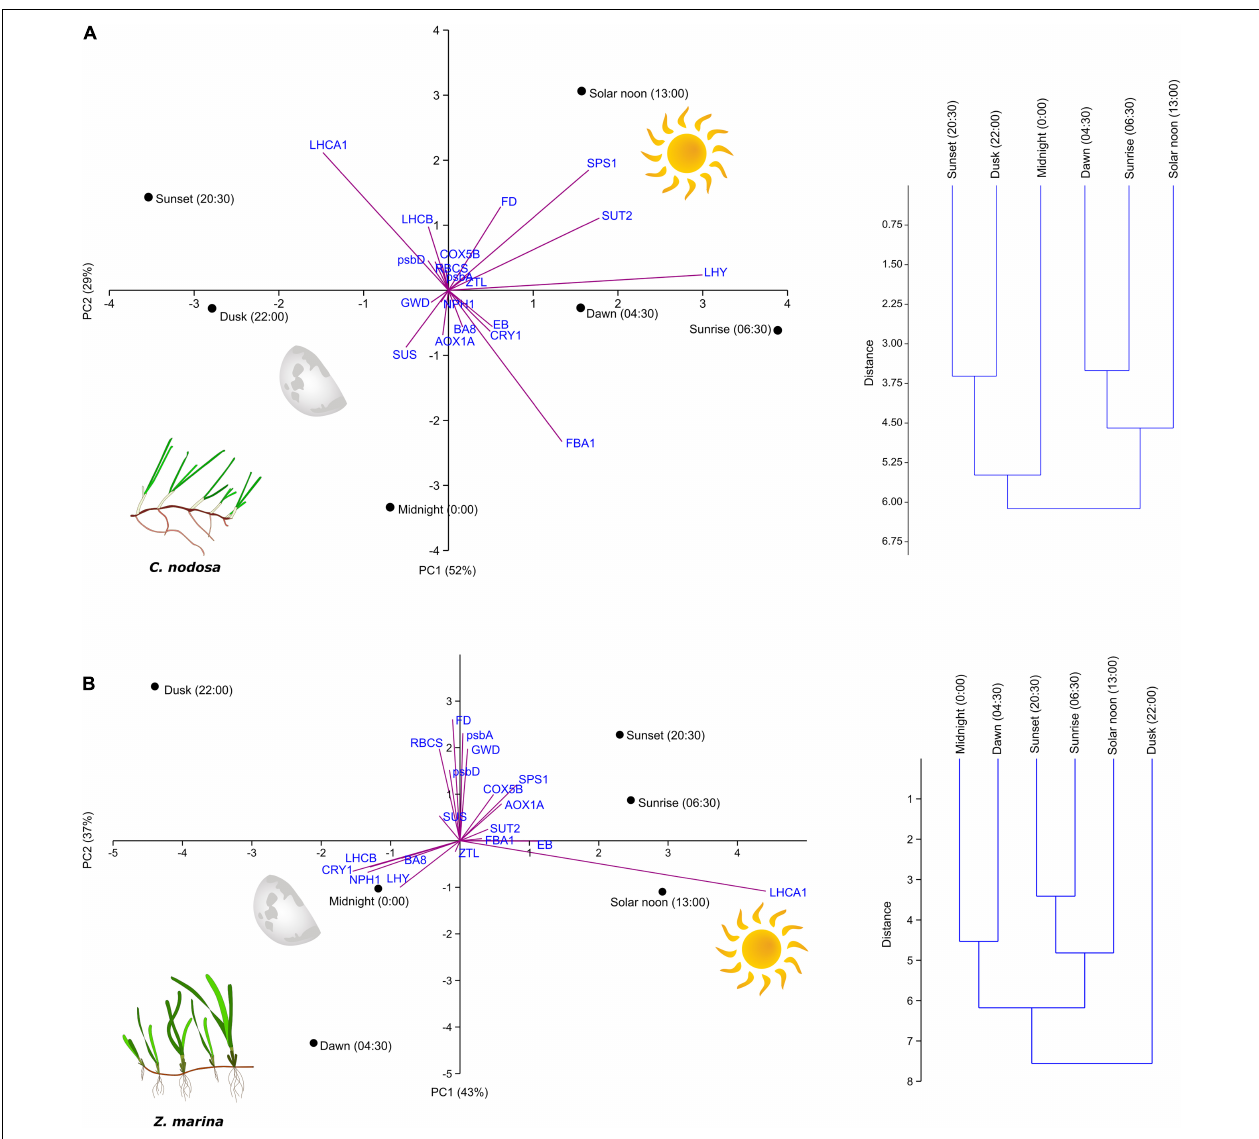
FIGURE 1 | Principal component analysis (PCA) with biplot and clustering based on multivariate gene-expression data in Cymodocea nodosa (A) and Zostera marina (B) ( n = 3). Transcript loadings are outlined in Supplementary Table 4 .